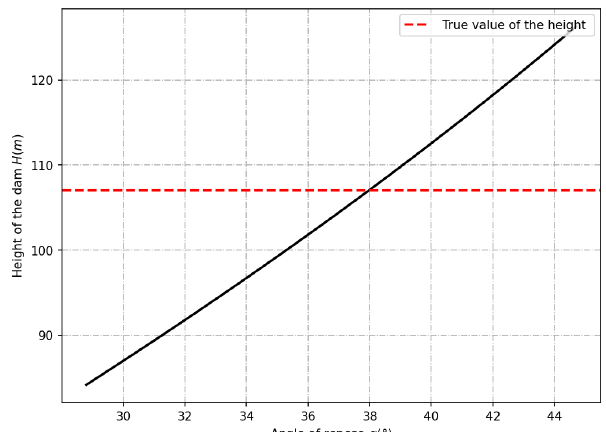
Figure 15. The relationship between the predicted result and the angle of repose.